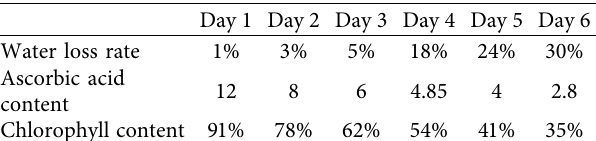
Table 3: Experimental data table of vegetable preservation based on PVC plastic film preservation technology.